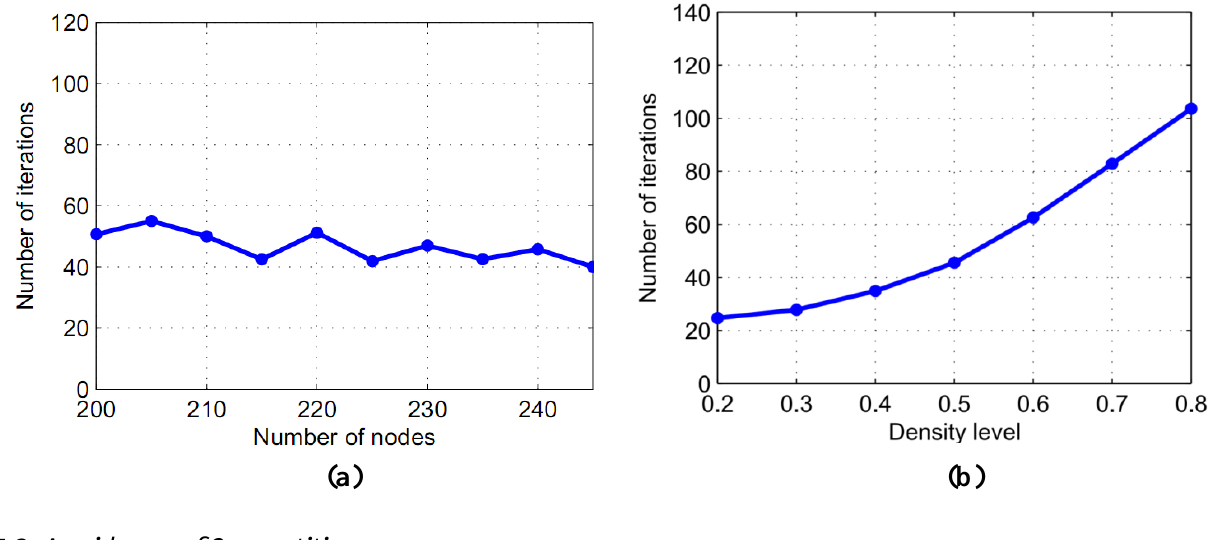
Figure 5. Relation about density and the numbers of iterations, nodes. (a) At the density 0.5; (b) Different